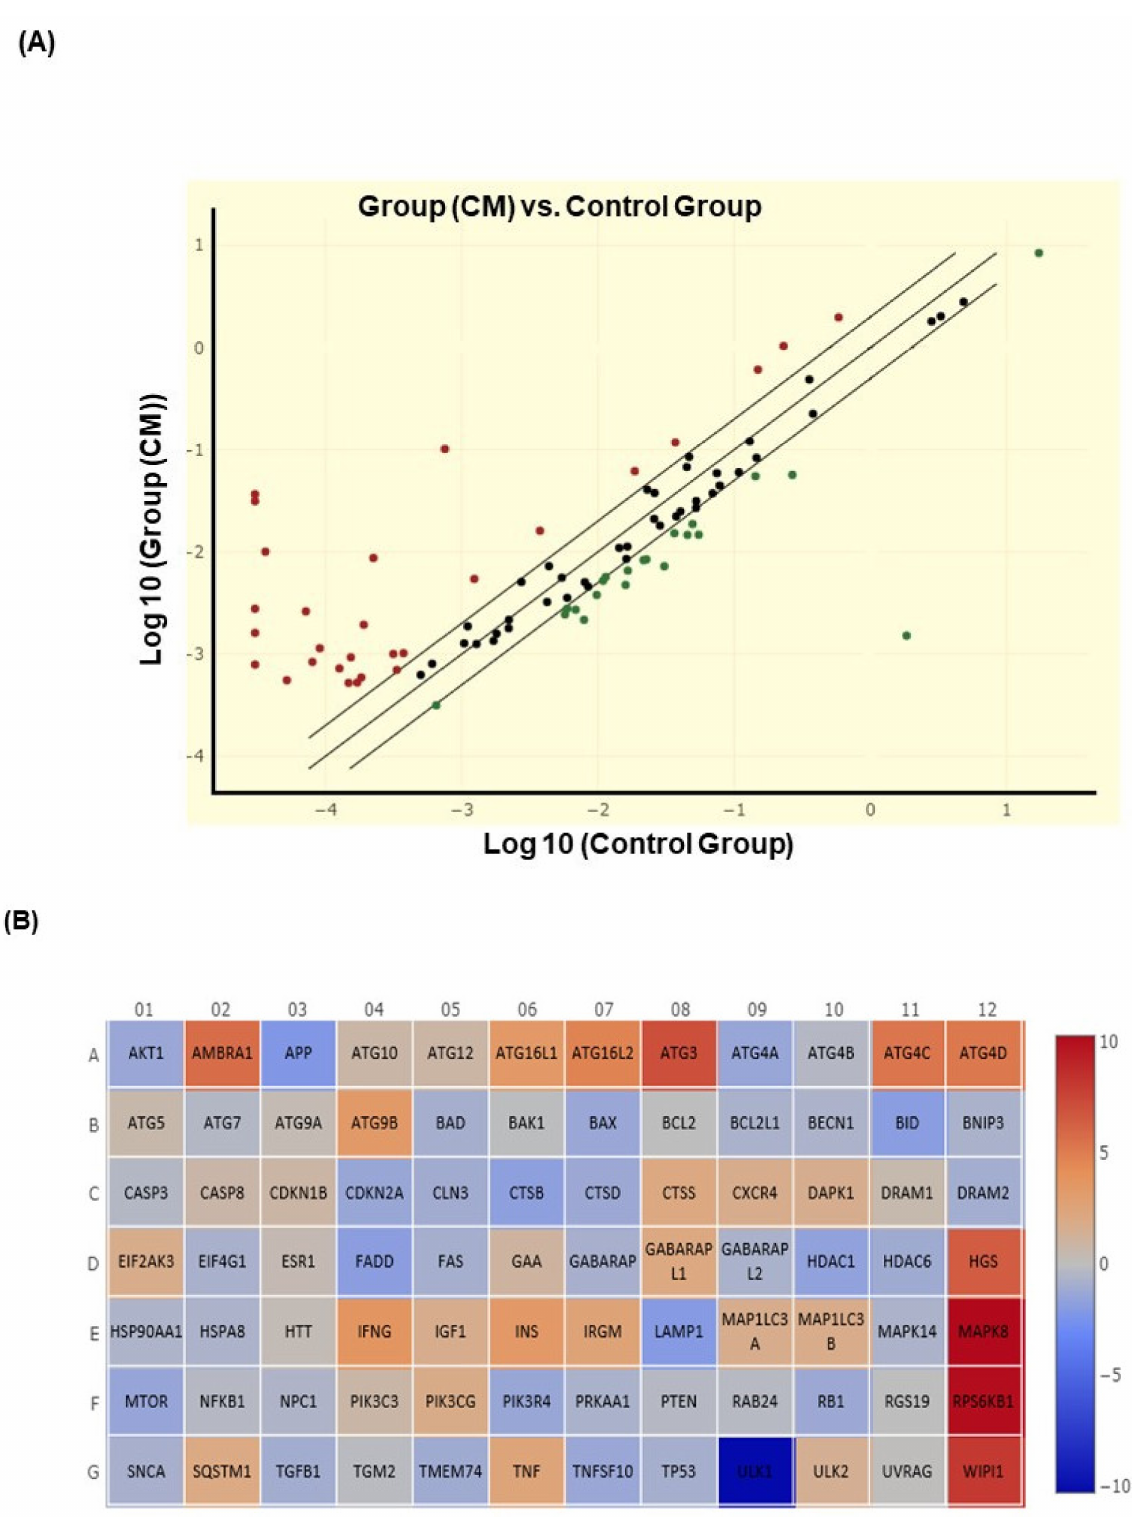
Figure 4. CM modulates genes involved in the regulation of the autophagy process. ( A ) Differential expression of autophagy-related genes between untreated and CM-treated Ca9-22 cells using RT 2 Profiler PCR Array tests. A total of 46 differential expressed autophagy genes were identified (up- or down-regulated more than twice). ( B ) Visualization of log2 fold changes and up/down-regulation by cannabinoid mixture compared to untreated